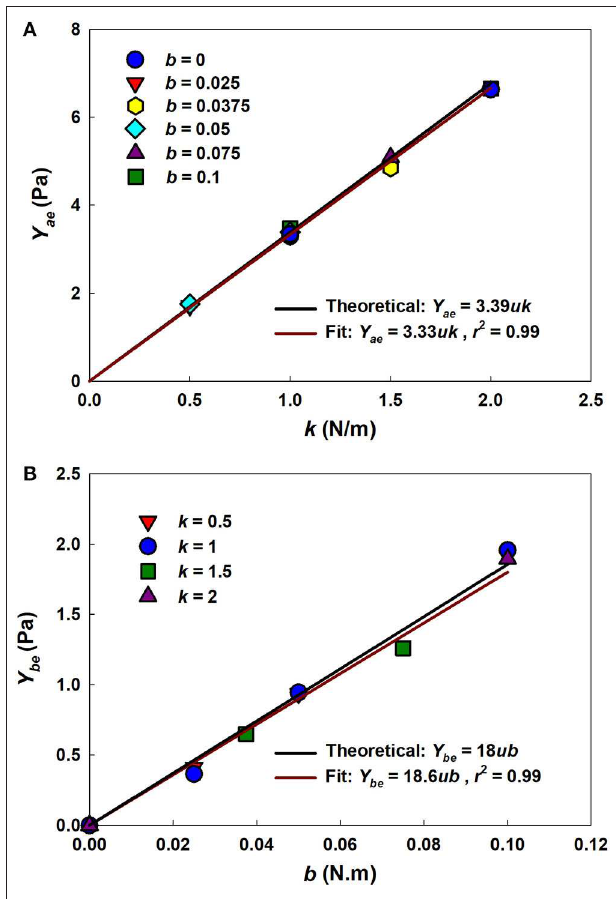
FIGURE 4 | Uniaxial model-based estimates of network parameters. (A) Y ae vs. k for different b values. (B) Y be vs. b for different k values. Solid black lines represent the theoretical relationships between network and model parameters. Solid dark red lines represent the fits with the r 2 as the adjusted coefficient of determination for the linear